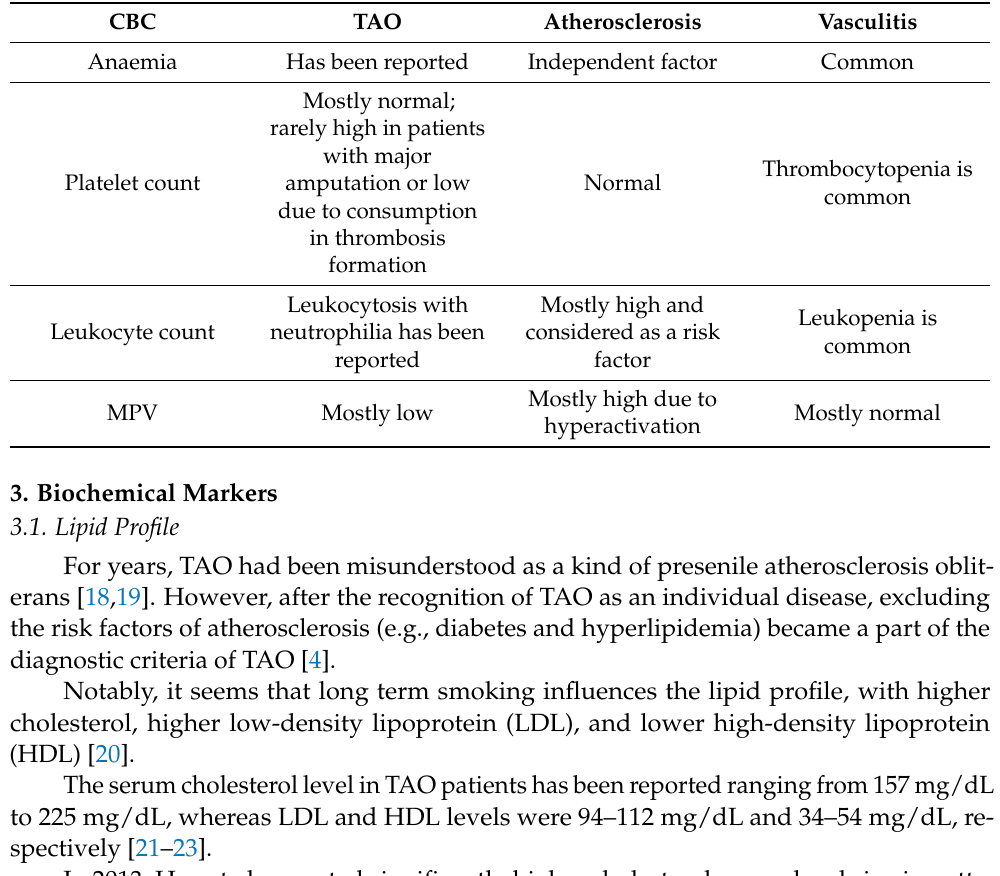
Table 1. Summary of the main findings on Complete Blood Count